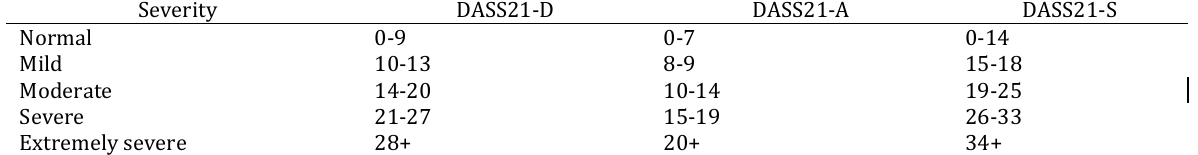
Table 1. Depression anxiety and stress 21 sub-scale severity ratings suggested for Australian